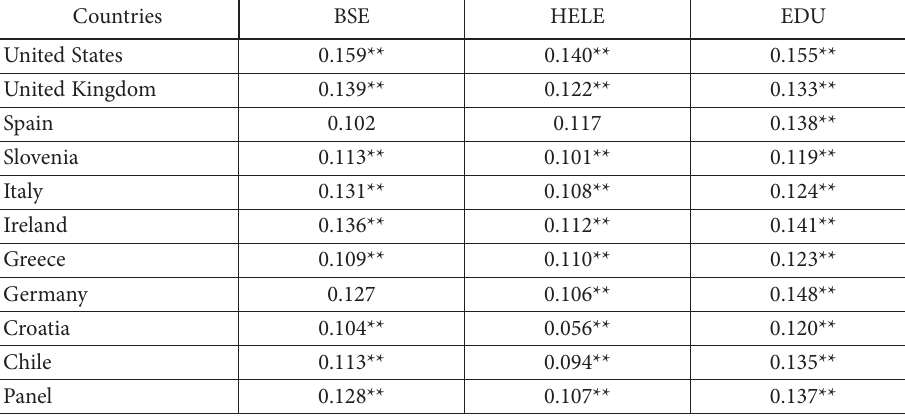
Table 7. FMOLS cointegration coefficients by FMOLS method